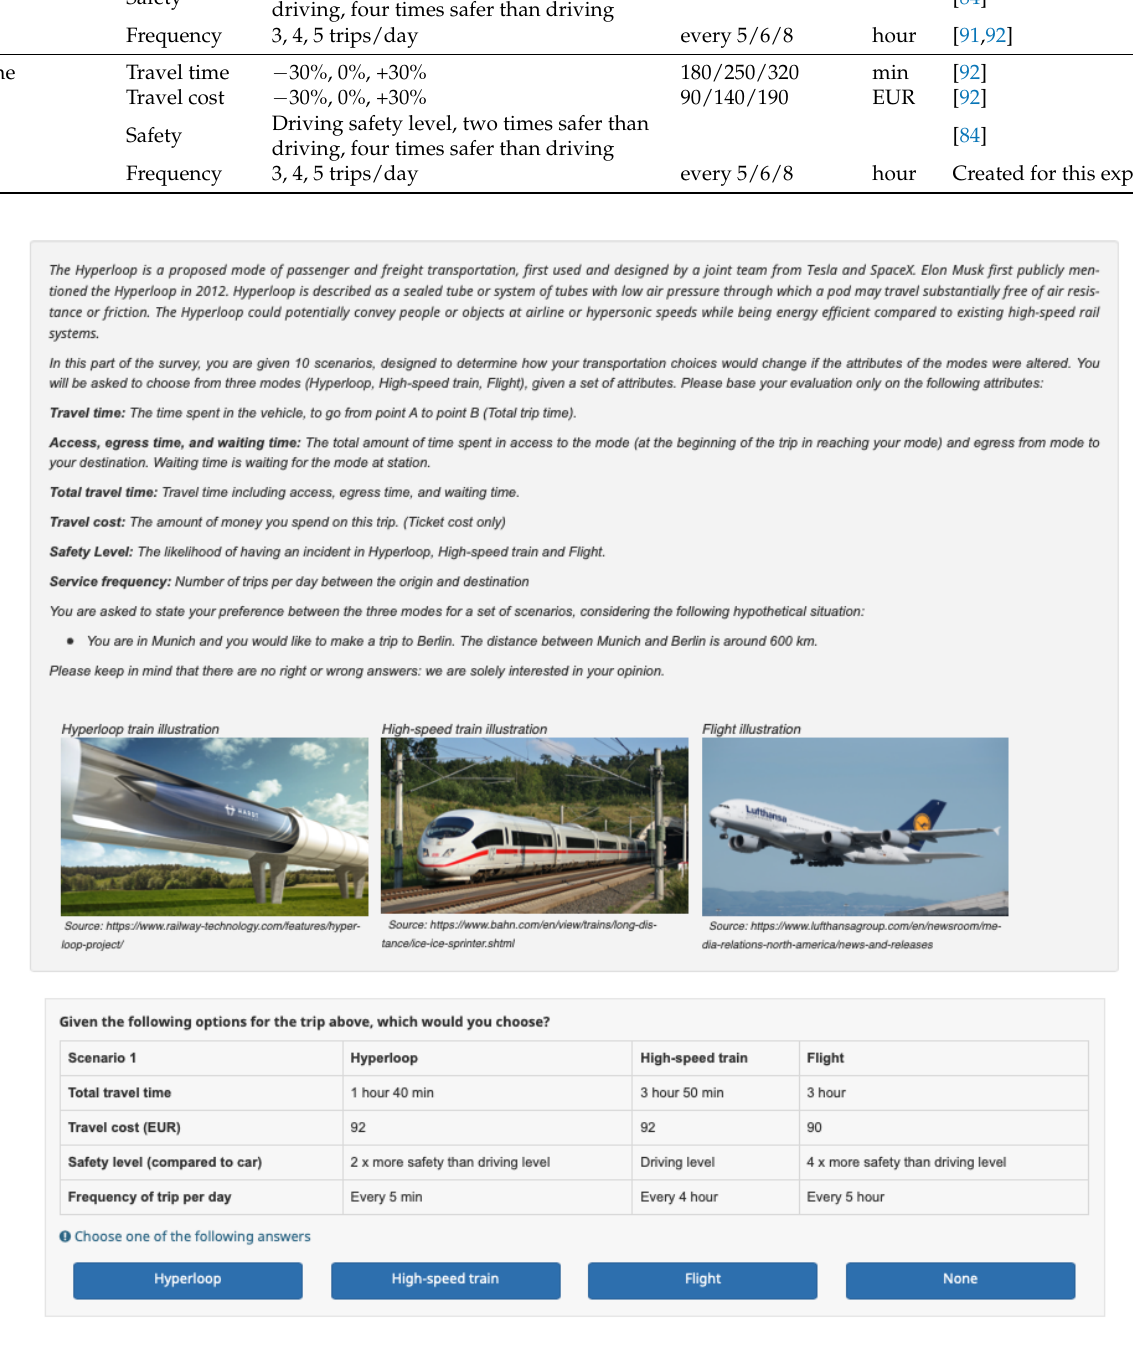
Figure 1. Survey block design